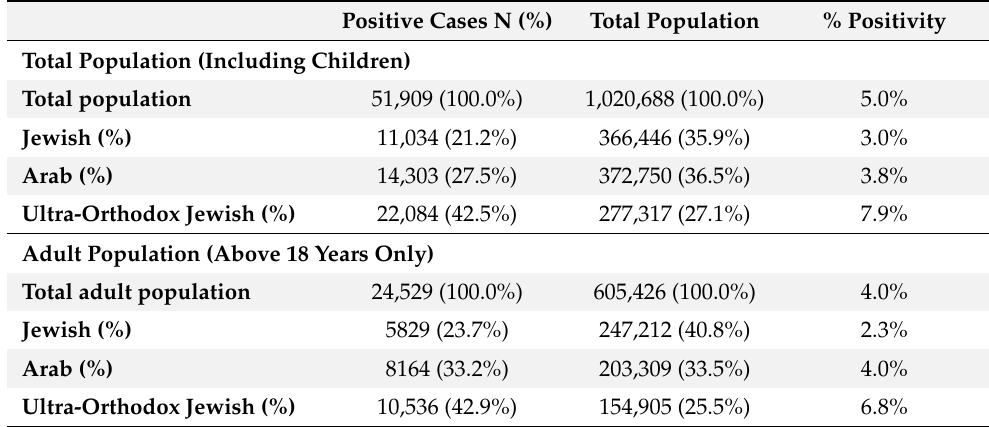
Table 2. Jerusalem SARS-CoV-2-positivity rates by ethnic sub-populations. Positive Cases N (%) Total Population %